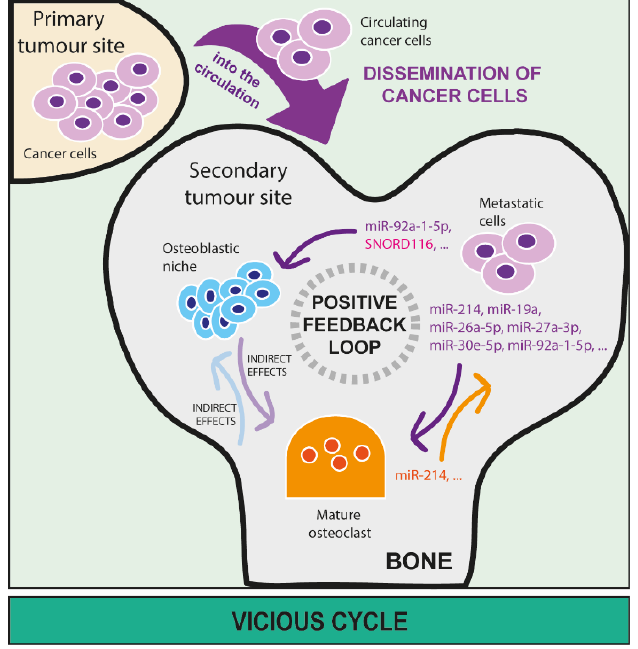
Figure 4. The role of microRNAs and snoRNAs in the vicious cycle in bone. MiRNA and snoRNA release by metastatic cancer cells in bone is directly involved in sustaining a positive feedback loop (also called ‘vicious cycle’) between cancer, osteoclast, and osteoblast cells that further worsen the unbalance of bone homeostasis due to the presence of metastasis. Once metastatic cells disseminate to bone through the blood circulation, they can seed and proliferate in this new micro-environment. Here, cancer-derived miRNAs can directly affect activities of both osteoclasts (miR-214, miR-19a, miR-26a-5p, miR-27a-3p, miR-30e-5p, miR-92a-1-5p, etc.) and osteoblasts (miR-92a-1-5p, SNORD166, etc.) as well as the relationship between osteoclasts and osteoblasts, leading to bone lesion formation. Additionally, miRNAs that derive from osteoclasts (miR-214, etc.) and osteoblasts can directly sustain the growth of metastatic cells in the bone marrow.